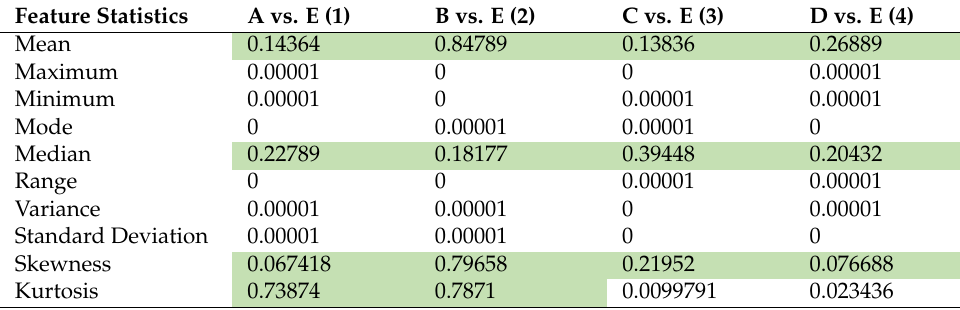
Table 3. Stage 2 of the feature selection process using Mann–Whitney U metric.